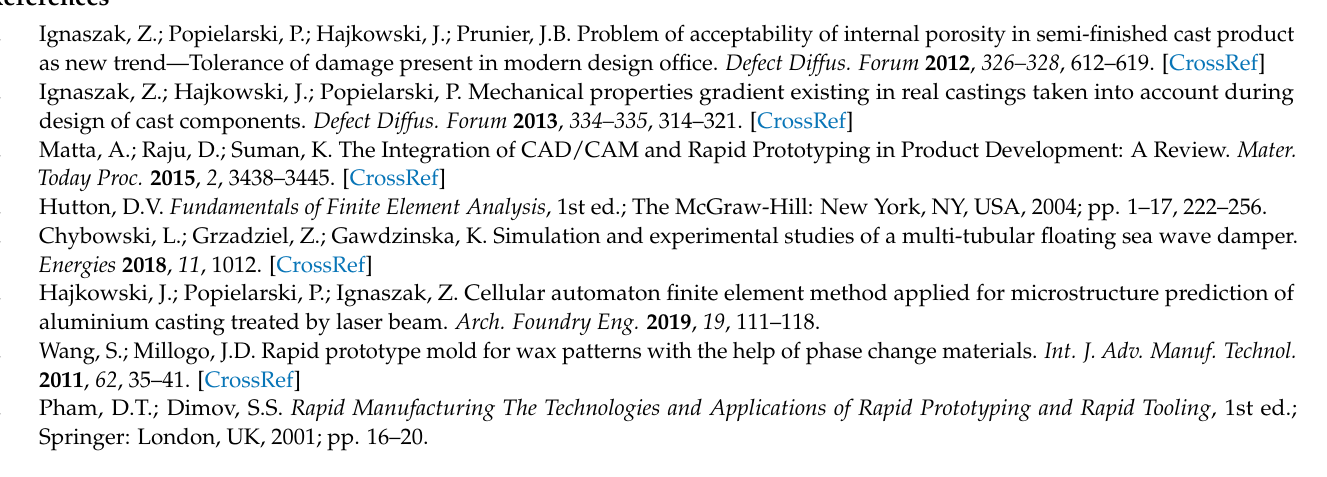
Table S2: Average sample